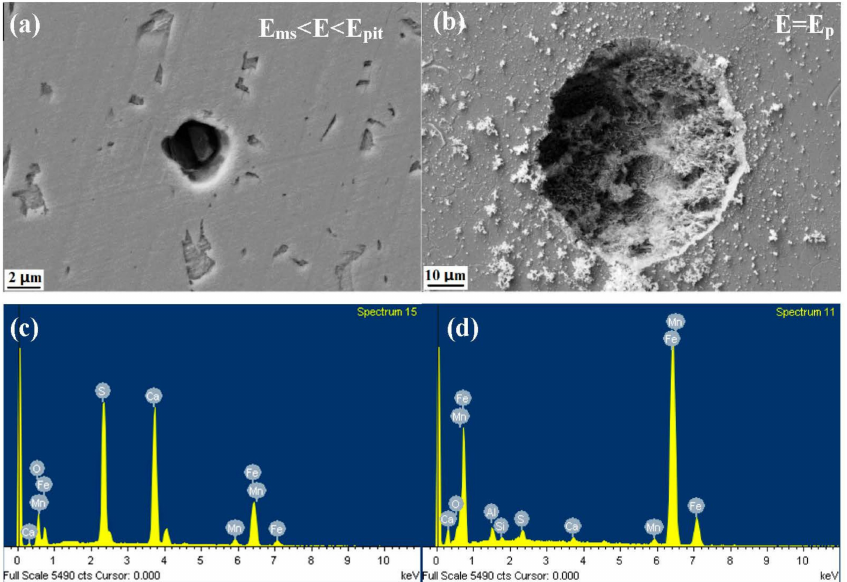
Figure 6. The morphology and EDS analysis of metastable pits at type C inclusion sites after the potentiodynamic polarization test. ( a , c ): E ms < E < E pit ; ( b , d ): E = E pit